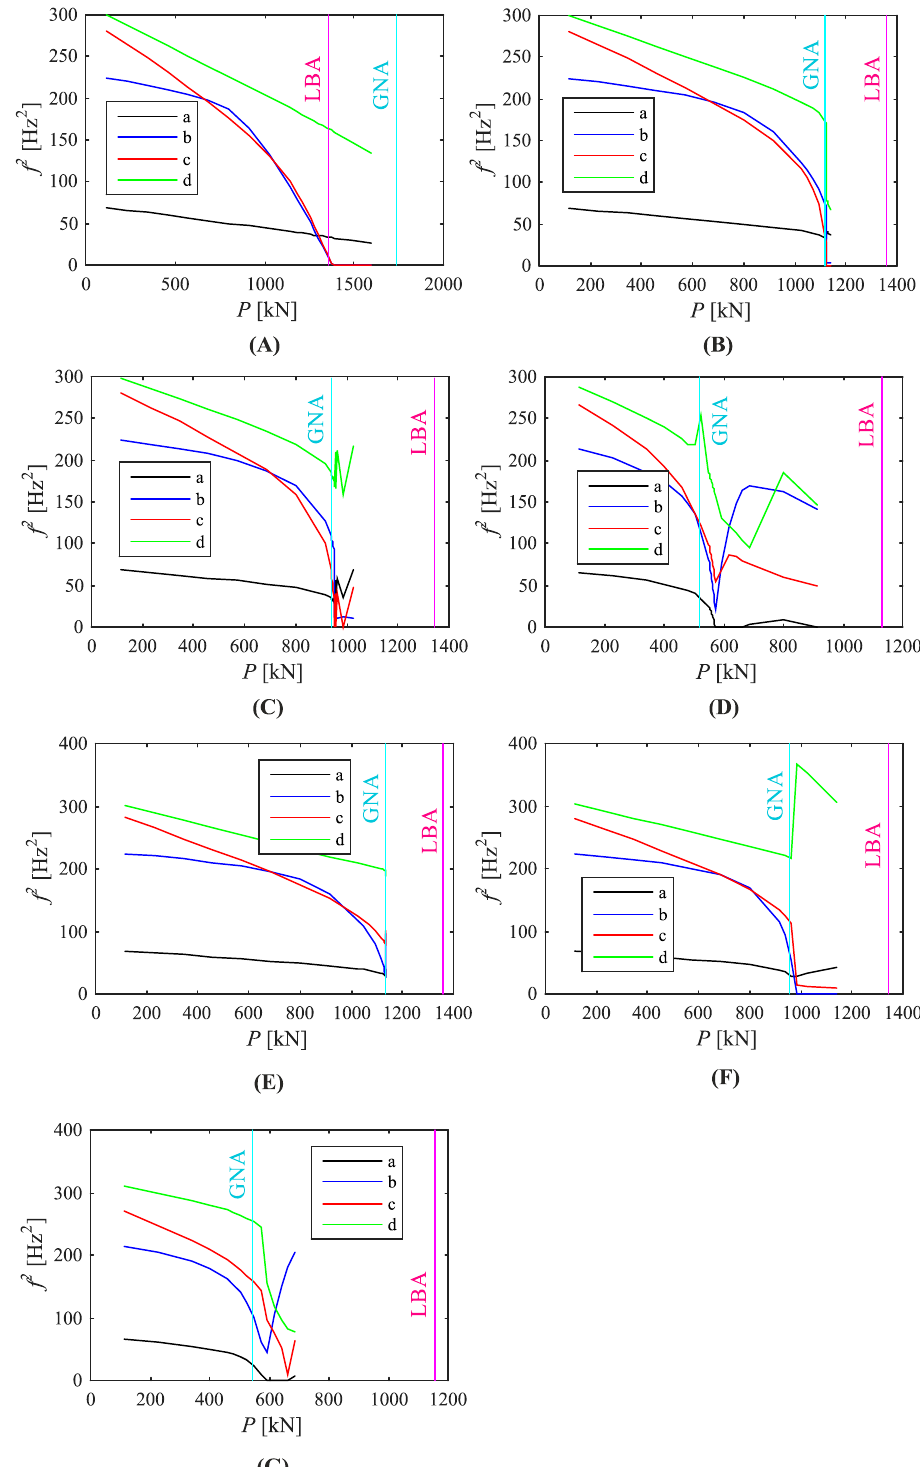
Figure 8. Relationship between applied load and squared natural frequencies ((a) first, (b) second, (c) third, (d) fourth) of the silo segment with initial geometrical imperfections: ( A ) none, ( B ) B1_2 mm, ( C ) B1_5 mm, ( D ) B1_20 mm, ( E ) B2_2 mm,